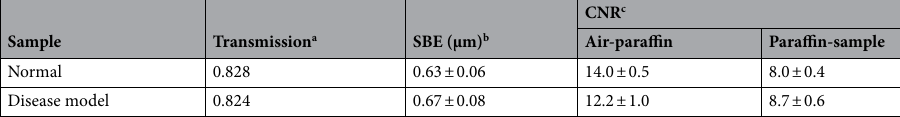
Table 1. Observation statistics. A value with range denotes an average with 95% confidence interval from five independent measurements. a Calculated value from the opacity histogram of a projection image at 0° of each data set; the peak opacity of sample was divided by the peak opacity of air. b Size of blurring at edges of paraffin-sample boundary; it was obtained based on Eq. 1 from a 7 μm line profile. c Calculated value from an opacity comparison between two selected regions (15 pixels × 15 pixels) in CT slices; indicated materials were compared based on Eq.